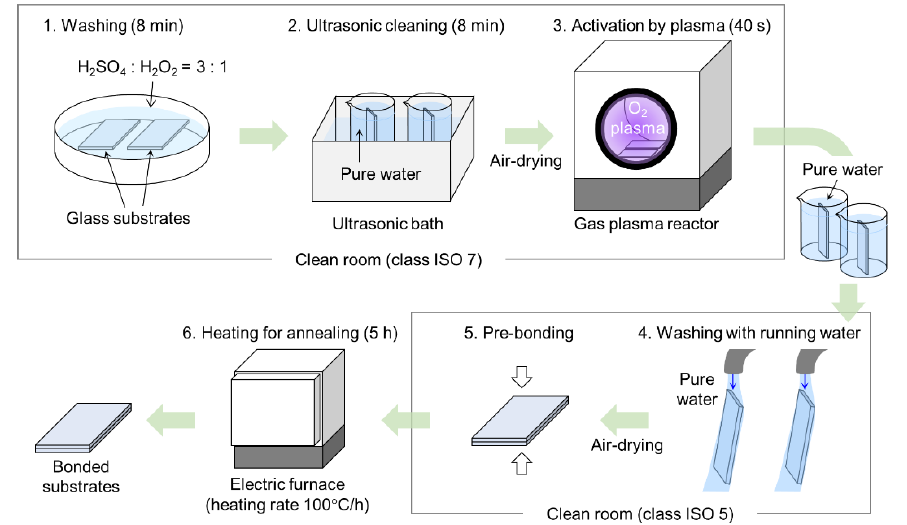
Figure 1. Schematic diagram of low-temperature bonding process for glass substrates utilizing typical facilities in clean rooms.